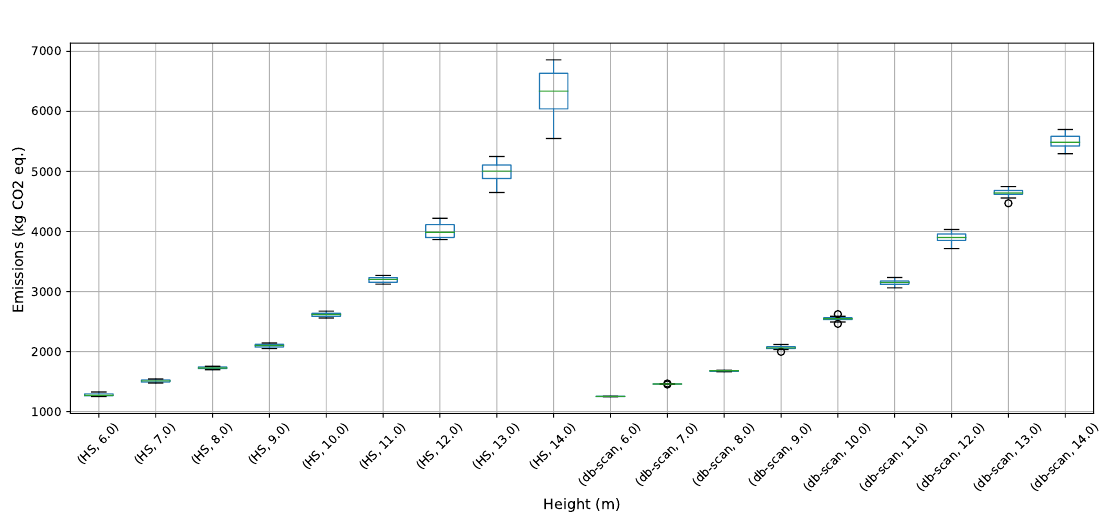
Figure 12. Cost box-plots, comparison between db-scan PSO and HS algorithms.